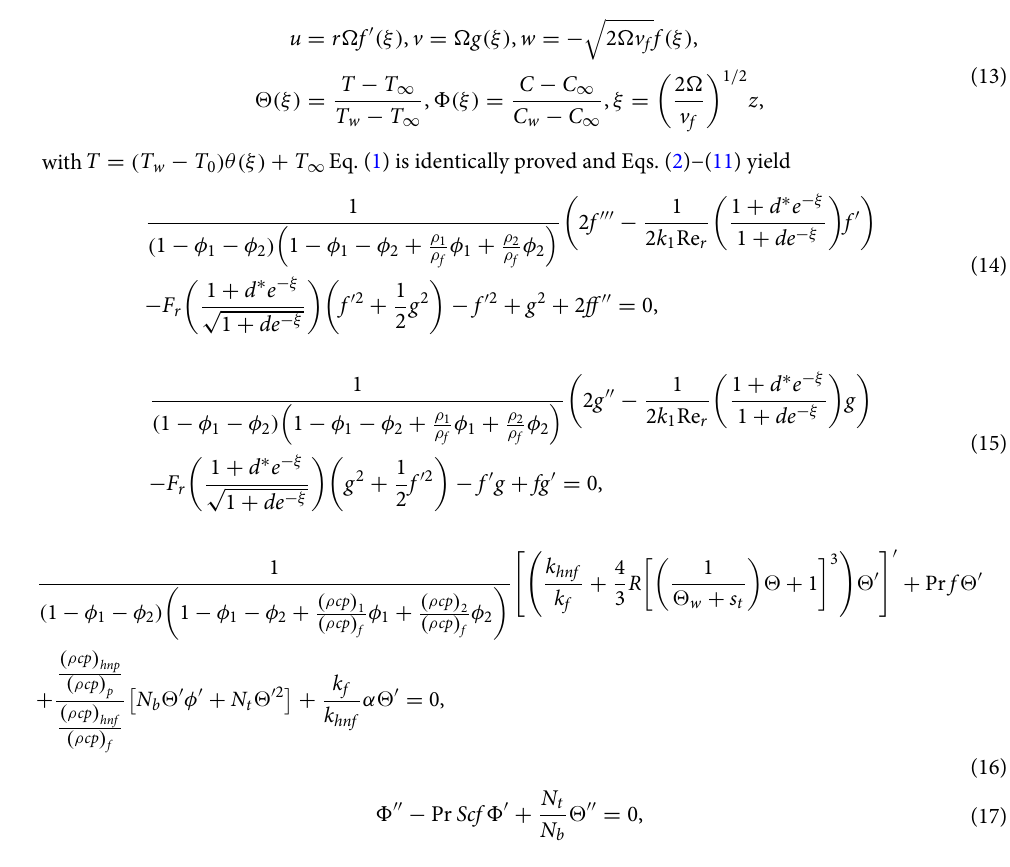
In the preceding formulations, the subscript hnf and f denoted the hybrid nanofluid and base fluid. k hnf (Thermal conductivity), φ 1 (Volume fraction of TiO 2 ), k 2 (Thermal conductivity of Al 2 O 3 ), φ 2 (Solid volume ρ c p fraction of Al 2 O 3 ), µ hnf (Effective dynamic viscosity), (Density), k 1 the thermal conductivity of TiO 2 , ρ 1 the density of TiO 2 , ρ 2 the density of Al 2 O 3 , and ρ f the density (cid:31) of base fluid. Thermo physical features of nanoparticles and water are showed in Table 1 15 below. Considering